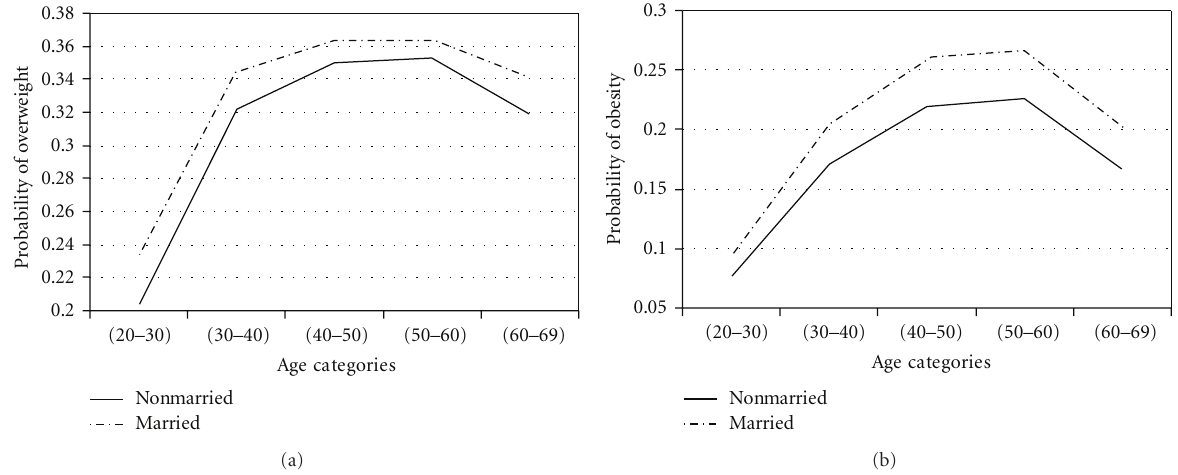
Figure 6: Probabilities of overweight and obesity across age groups for marital